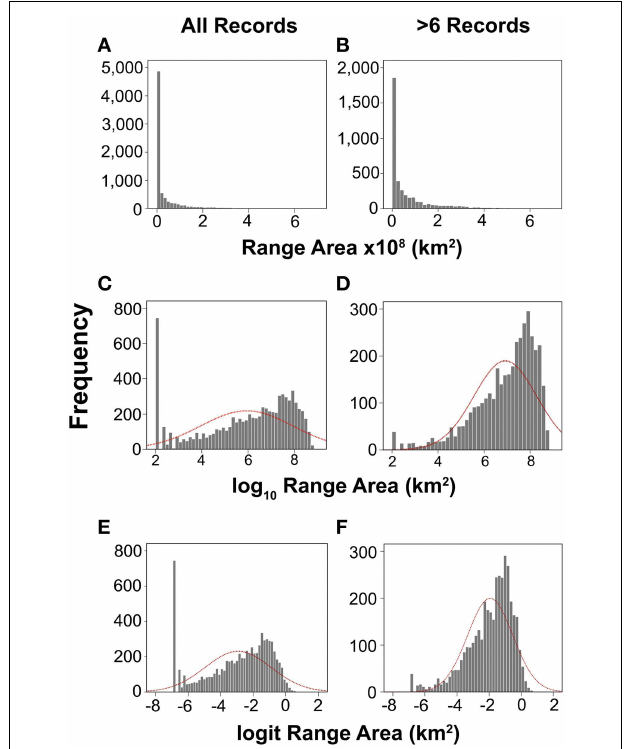
FIGURE 4 | Range size frequency diagrams for all species (A,C,E) and only species with 6 or more records (B,D,F). Dashed red lines show normal distribution with parameters derived from the